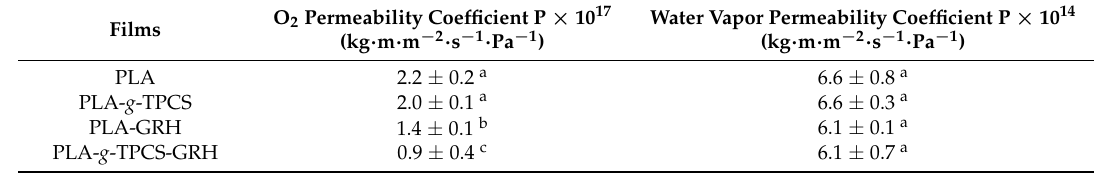
Table 7. Barrier properties of films to oxygen and water vapor at 30% relative humidity (RH) and 23 ◦